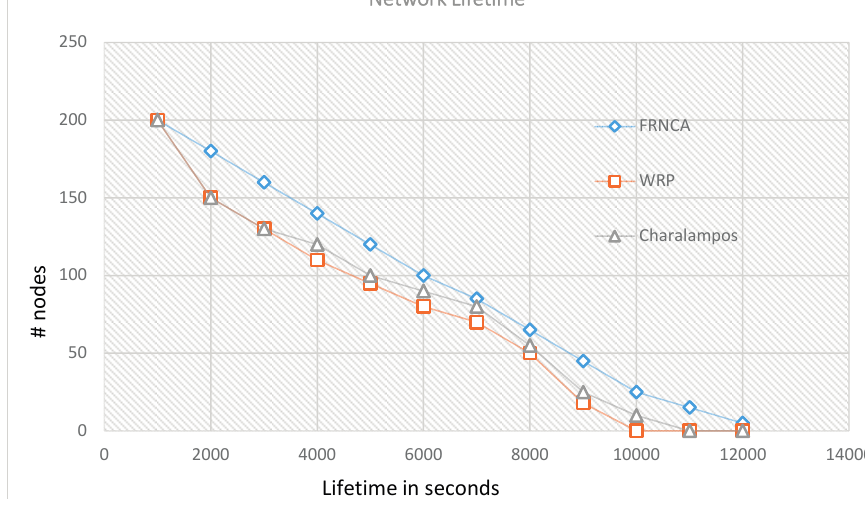
Figure 6. Network Lifetime for FNRCA, WRP and Charalampos using the same initial energy